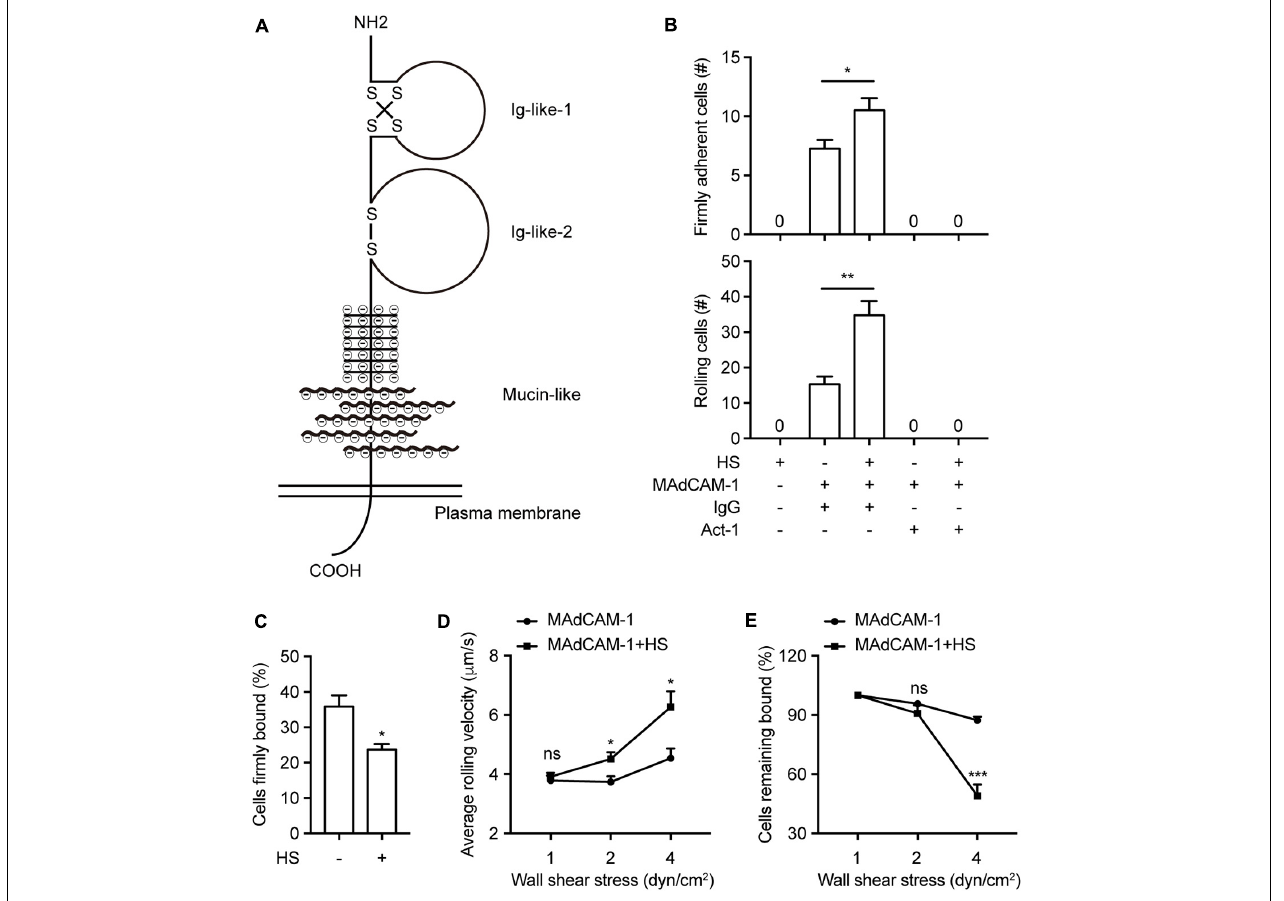
FIGURE 1 | HS on the surface promotes integrin α 4 β 7-mediated cell adhesion to immobilized MAdCAM-1. (A) Schematic diagram of the structure of MAdCAM-1, the extracellular domain of MAdCAM-1 includes Ig-like-1, Ig-like-2 and mucin-like (serine/threonine-rich) three domains. (B–E) Adhesive behaviors of 293T- α 4 β 7 cells on immobilized HS (100 µ g/ml) or MAdCAM-1 (25 µ g/ml) substrates in 1 mM Ca 2 + /Mg 2 + . The number of rolling and firmly adherent 293T- α 4 β 7 cells was measured at a wall shear stress of 1 dyn/cm 2 . Cells were pre-treated with murine IgG (10 µ g/ml) or α 4 β 7 blocking antibody Act-1 (10 µ g/ml) for 10 min at 37 ◦ C (B) . Percentage of cells firmly bound to ligand at a wall shear stress of 1 dyn/cm 2 (C) . Average rolling velocity of 293T- α 4 β 7 cells that adhered to MAdCAM-1 substrates at indicated wall shear stresses (D) . Resistance of 293T- α 4 β 7 cells to detachment at increasing wall shear stresses. The total number of cells remaining bound at each indicated wall shear stress was determined as a percent of adherent cells at 1 dyn/cm 2 (E) . One representative result of three independent experiments is shown in (B–E) . Data represent the mean ± SEM ( n ≥ 3) in (B–E) . * p < 0.05, ** p < 0.01, *** p < 0.001, ns: not significant (Student’s t